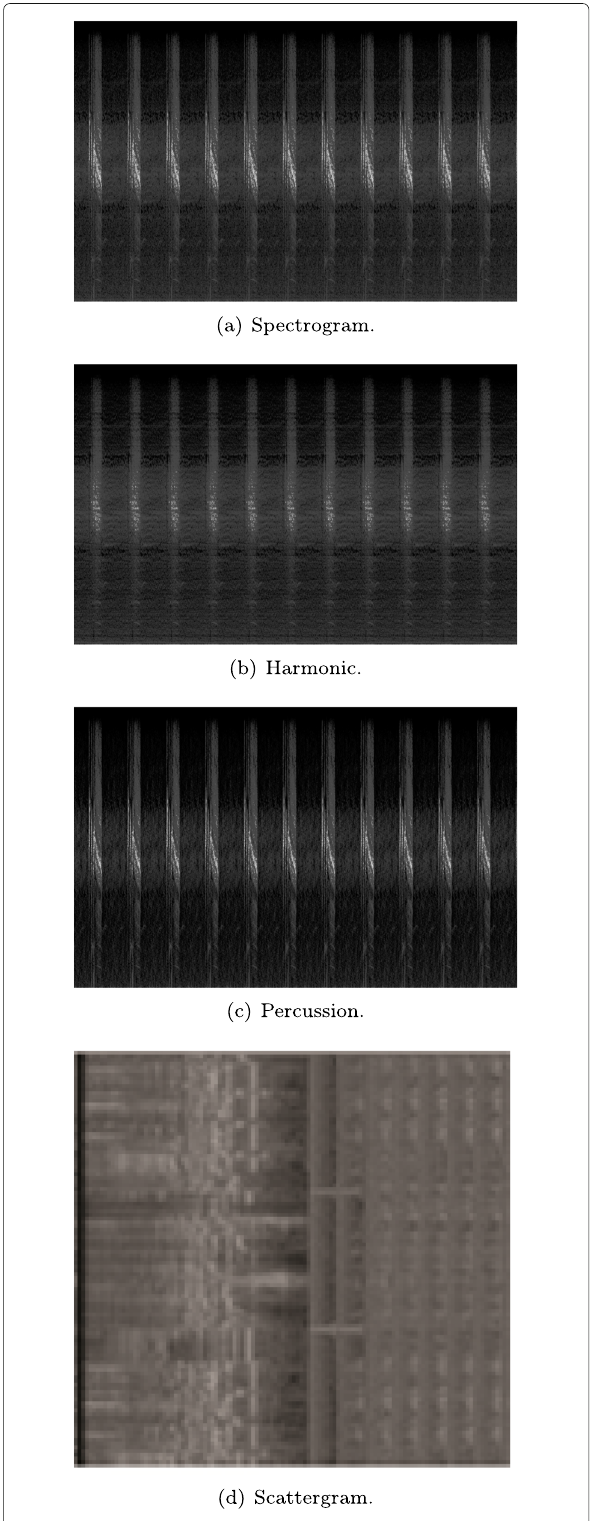
Fig. 2 Four types of audio images extracted from the audio signals. In all representation, the horizontal axis regards to time, and the vertical axis regards to